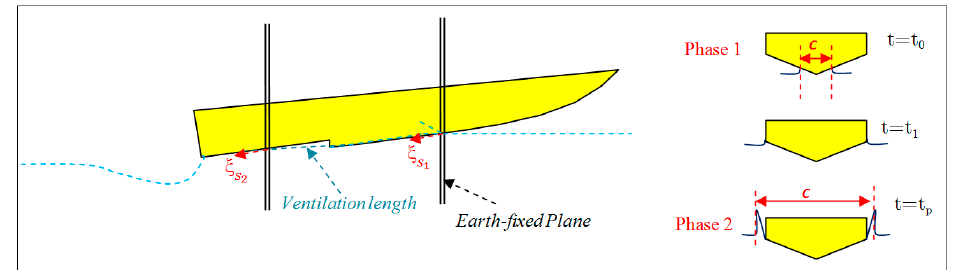
Figure 2. The 2D + T theory for single-stepped planing hull; it passes through a fixed two-dimensional observation plane for each planing surface ( left ); water entry problem for each planing surface from t = t 0 to t p ( right ).